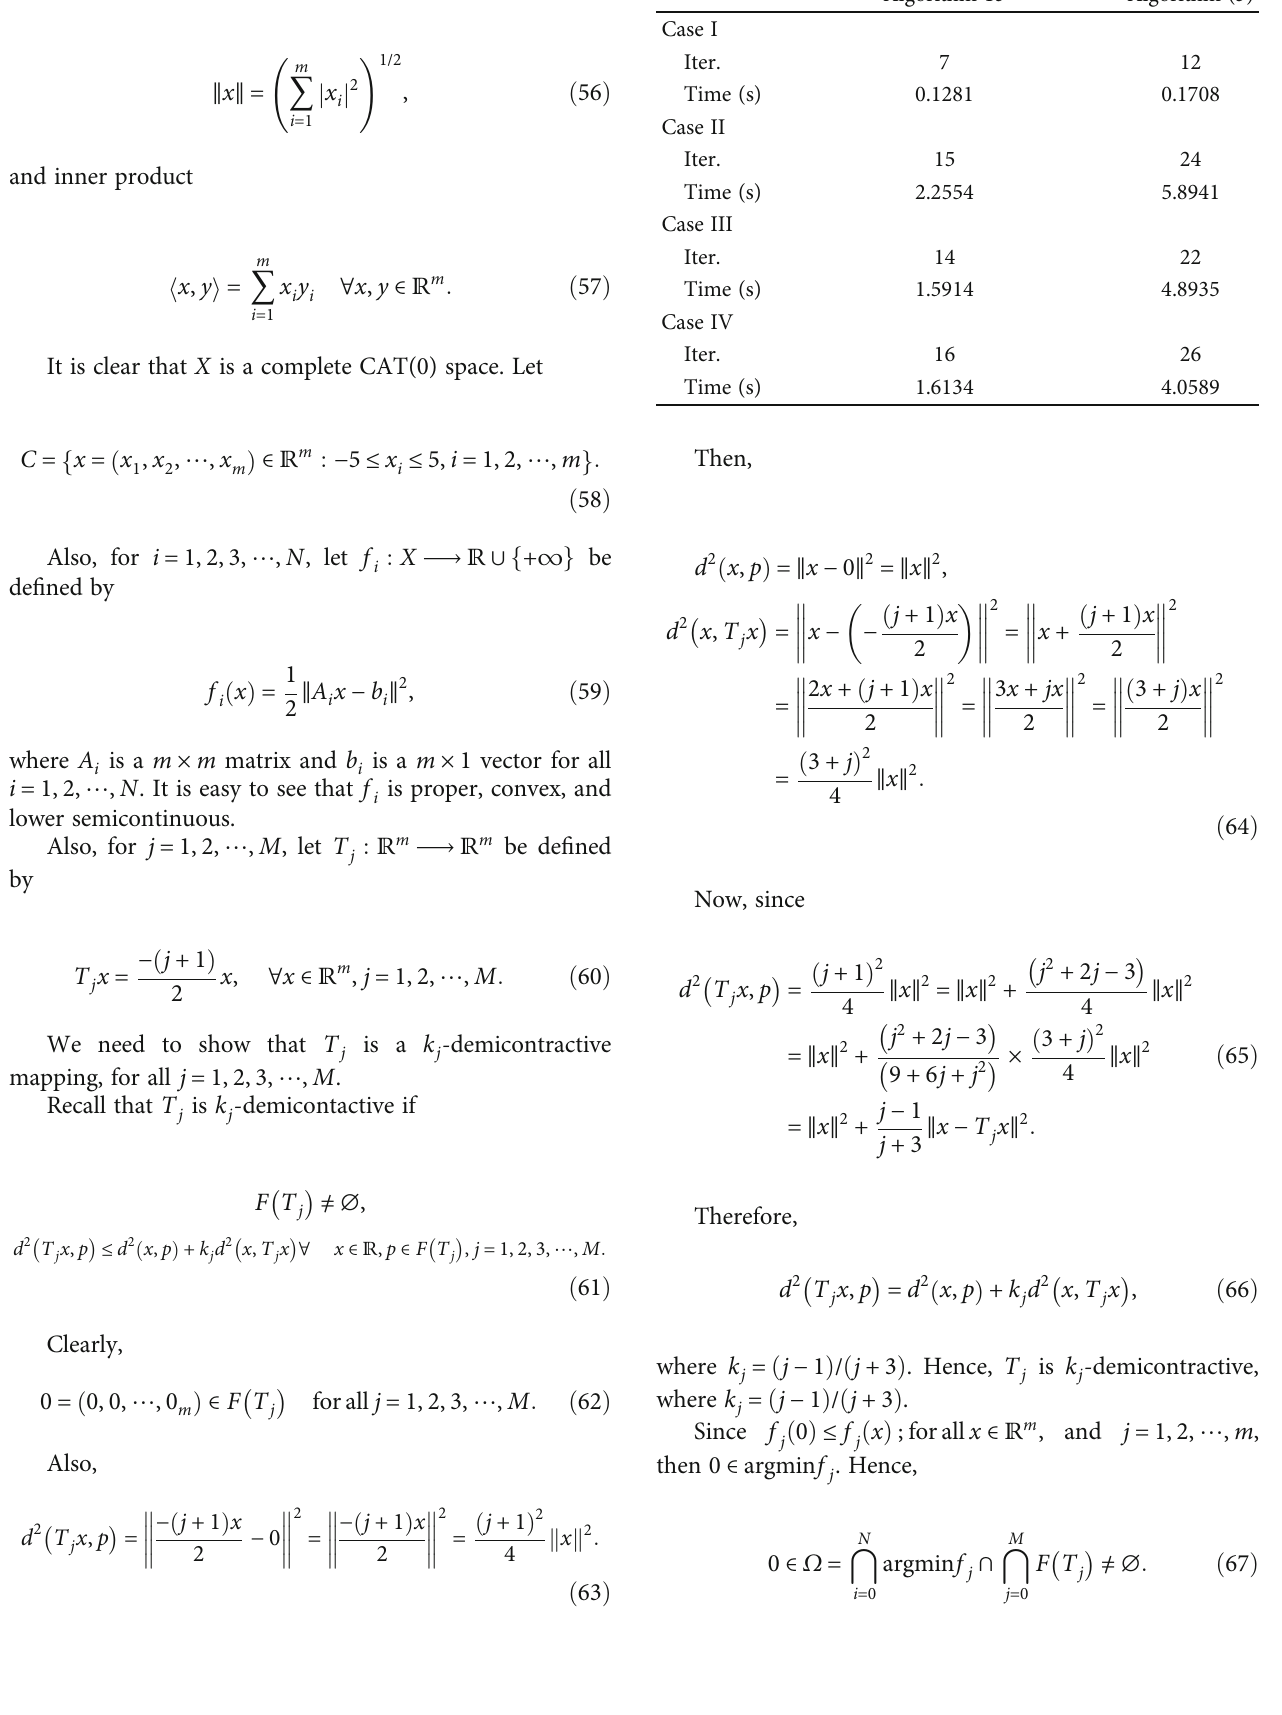
Table 1: Computation result for Example 23. Algorithm 15 Algorithm